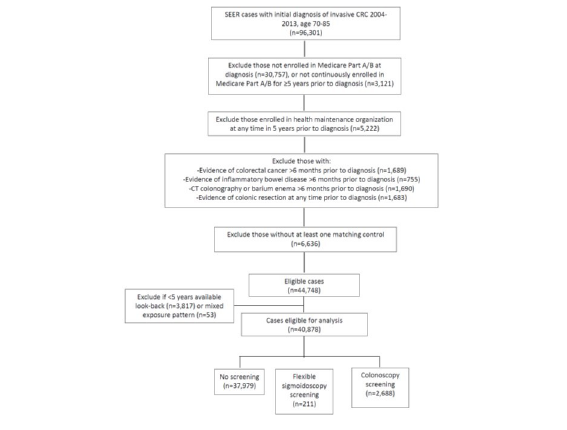
Fig 2. Selection of cases. CRC–colorectal cancer; SEER–Surveillance, Epidemiology, and End-Results.